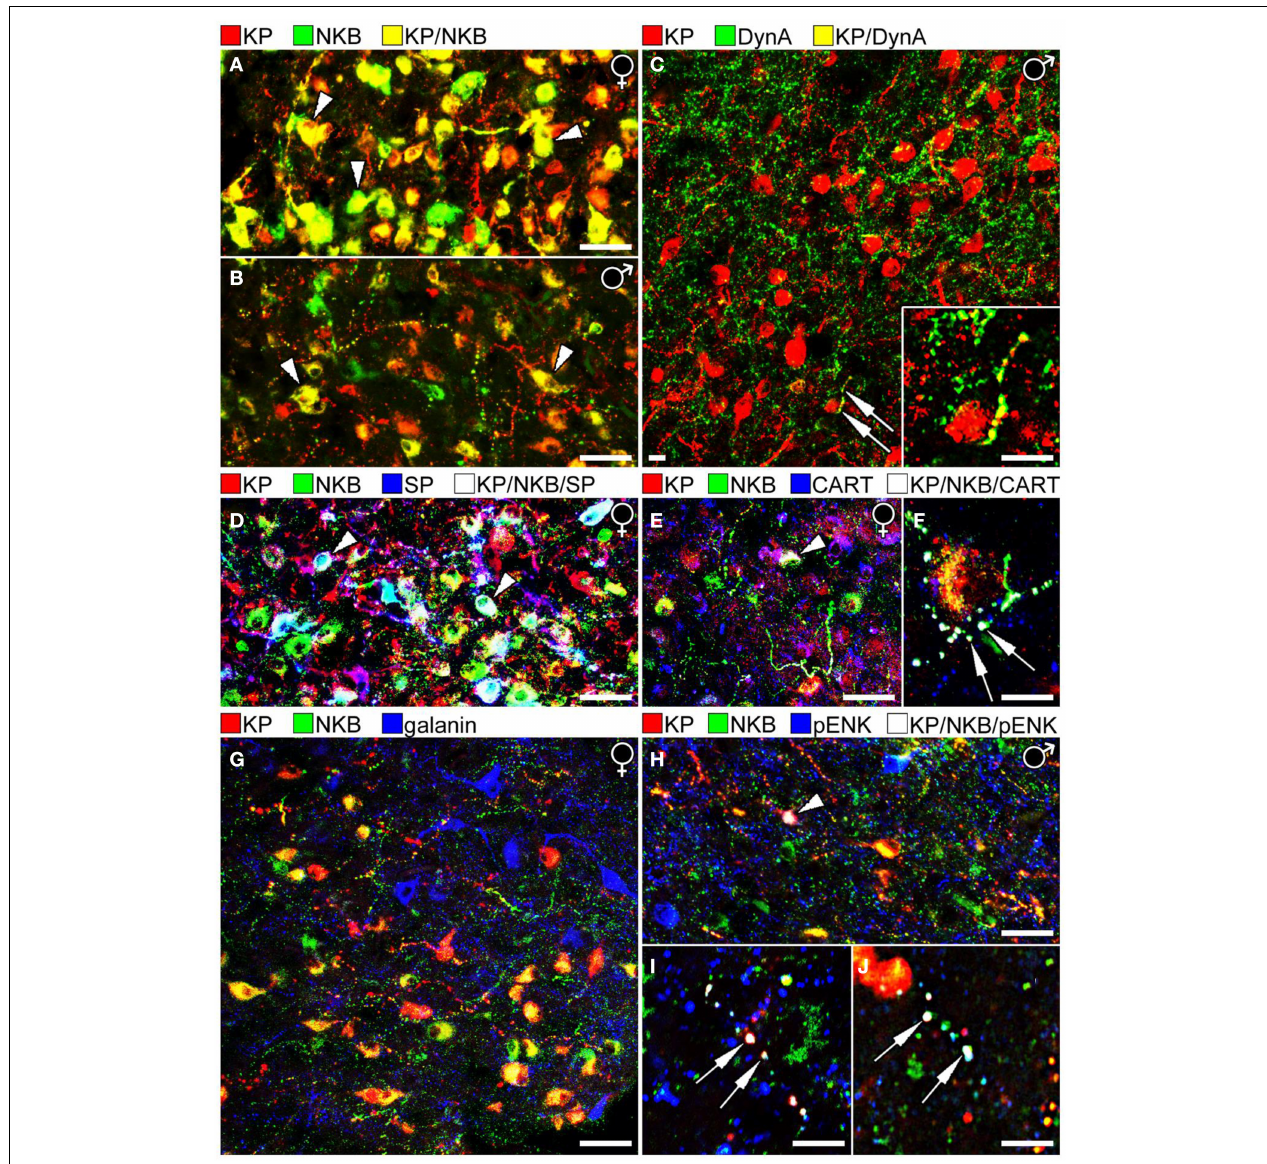
FIGURE 1 | Results of immunofluorescent studies to characterize the neuropeptide phenotype of human KP neurons in the Inf. (A,B) The highest numbers of KP and NKB neurons and colocalization percentages can be observed in the Inf of postmenopausal women (A) . Compare to the weaker labeling of the Inf from a 67 year-old men in (B) . Note that the Inf contains many single-labeled axons (red and green), in addition to dual-labeled ones (yellow) in both sexes. (C) Unlike KP neurons of laboratory animals, the majority of human KP neurons do not contain Dyn A immunoreactivity. A rare case of dual-labeled KP/Dyn A axon (arrows) is shown at higher power in the inset. (D) KP neurons often contain SP immunoreactivity in postmenopausal women. White cells labeled by arrowheads correspond to KP/NKB/SP triple-phenotype neurons (Hrabovszky et al., 2013). (E,F) Similarly, CART is